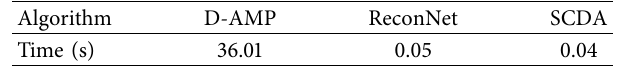
Table 10: The number of network parameters for 10 images (the measurement rate is 0.10).